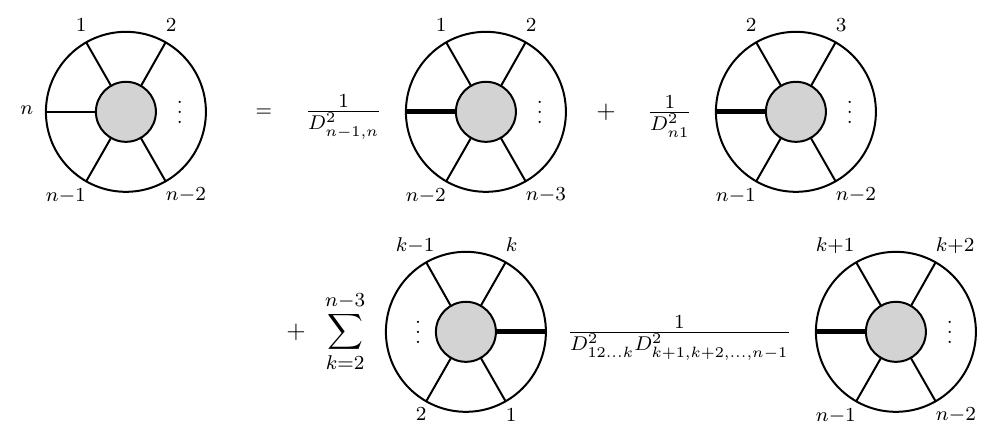
Figure 1 . Diagrammatic depiction of the recursion relation from (4.34). The new external states (bold) have conformal generators determined by the Ward identities P the right-hand side